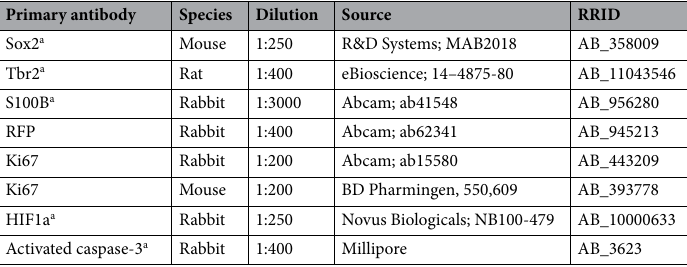
Table 1. Antibodies employed in this study. a Required antigen